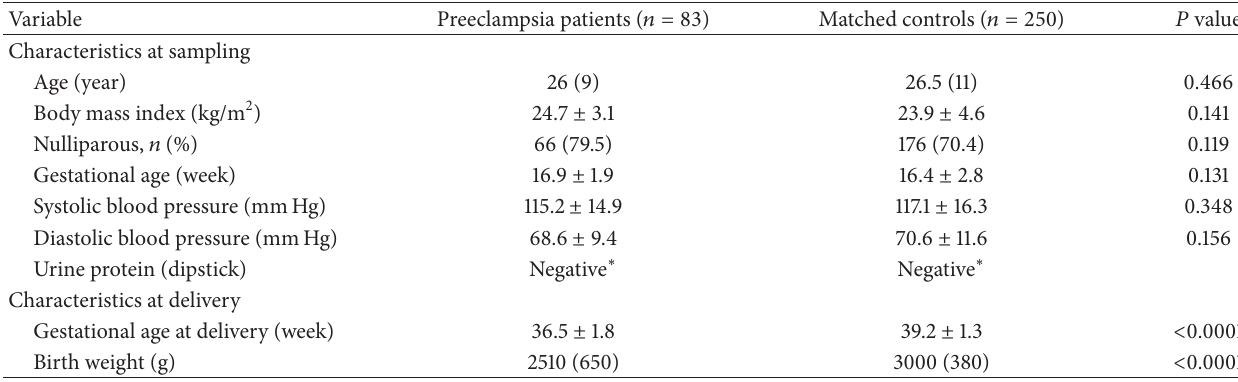
Table 1: Demographic and clinical characteristics of women with normotensive pregnancies and women who eventually developed preeclampsia.